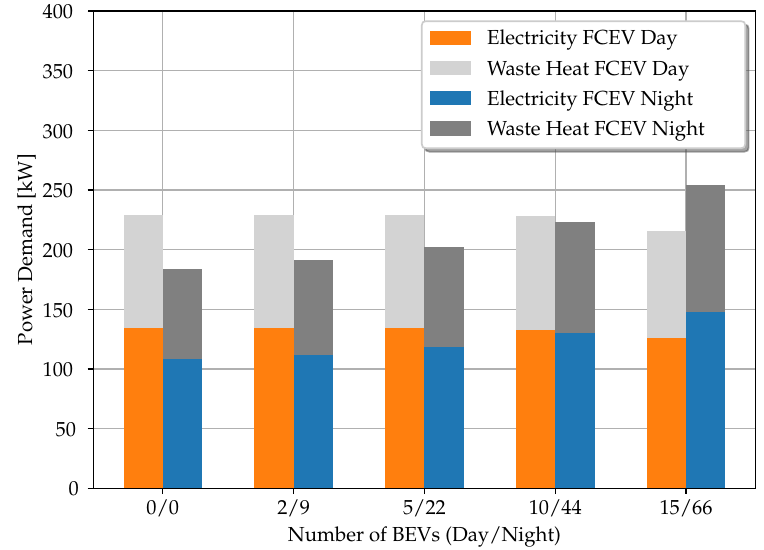
Figure 6. Power demand in the neighbourhood with optimally dimensioned storage capacities. The X-axis shows the scenarios considered resp. the relative number of employees in the neighbourhood who use a BEV daily for commuting and charge it in the neighbourhood during the other half of the day according to their working hours. The information in brackets behind the percentage figure indicates the period in which the cars are charged (daytime/nighttime).